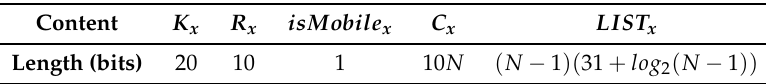
Table 3. The HELLO Packet Length of DIVE